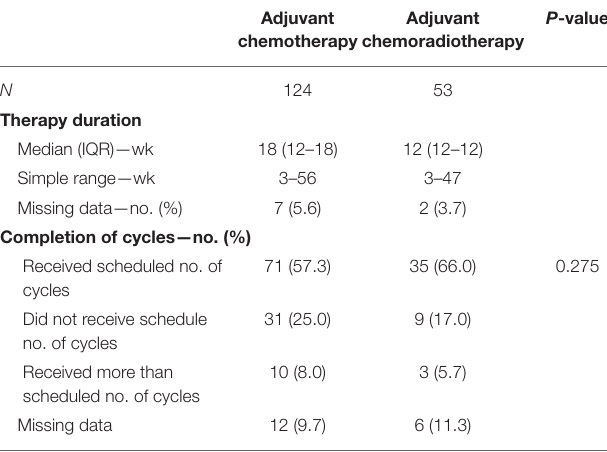
TABLE 3 | Treatment adherence, according to adjuvant strategy.